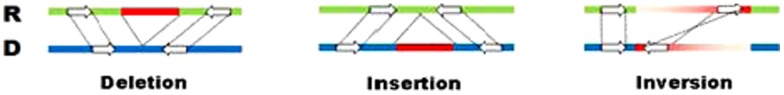
Structural variants and the read pairs that support them.Pairs from a donor genome “D” have distinct characteristics when mapped to a reference genome “R” for different types of structure variants.